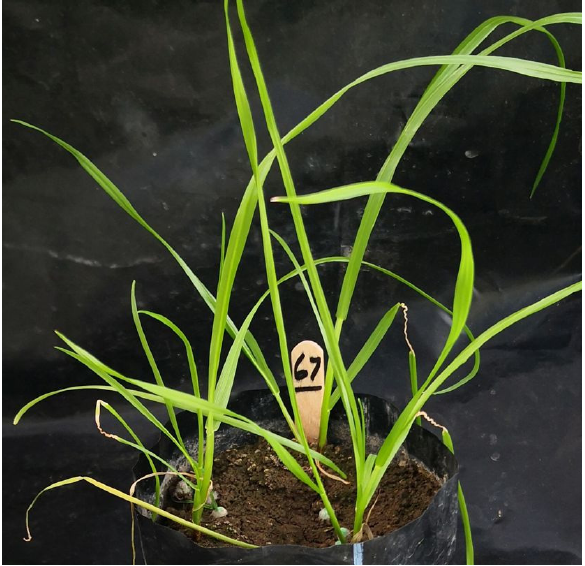
Figure 4. Lolium multiflorum plants treated with 5 J at 6 kV shows characteristic leaf deformation still present 28 DAT.